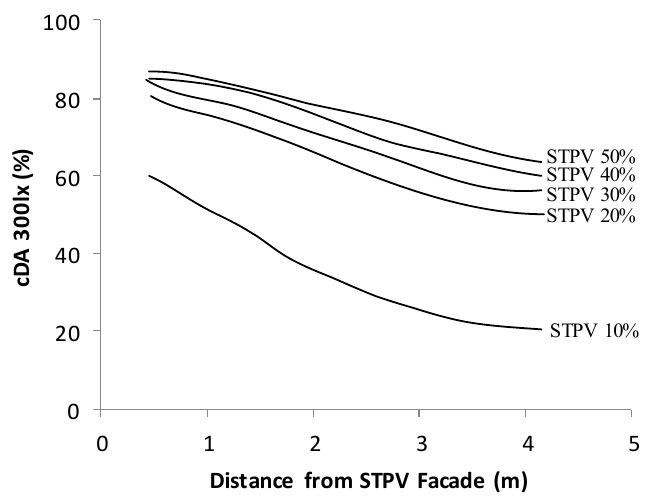
Figure 6. Spatial Daylight Autonomy for a BIPV façade with various visible effective transmittances (10% to 50%) [37].